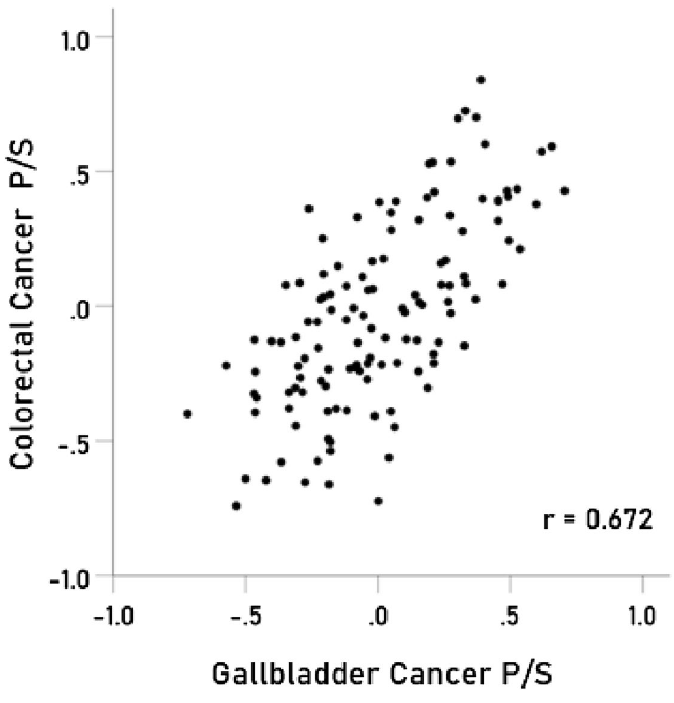
Figure 6. Immunogenetic P/S estimates for colorectal cancer are plotted against those for the cancer of gallbladder. P < 0.001; N = 127.